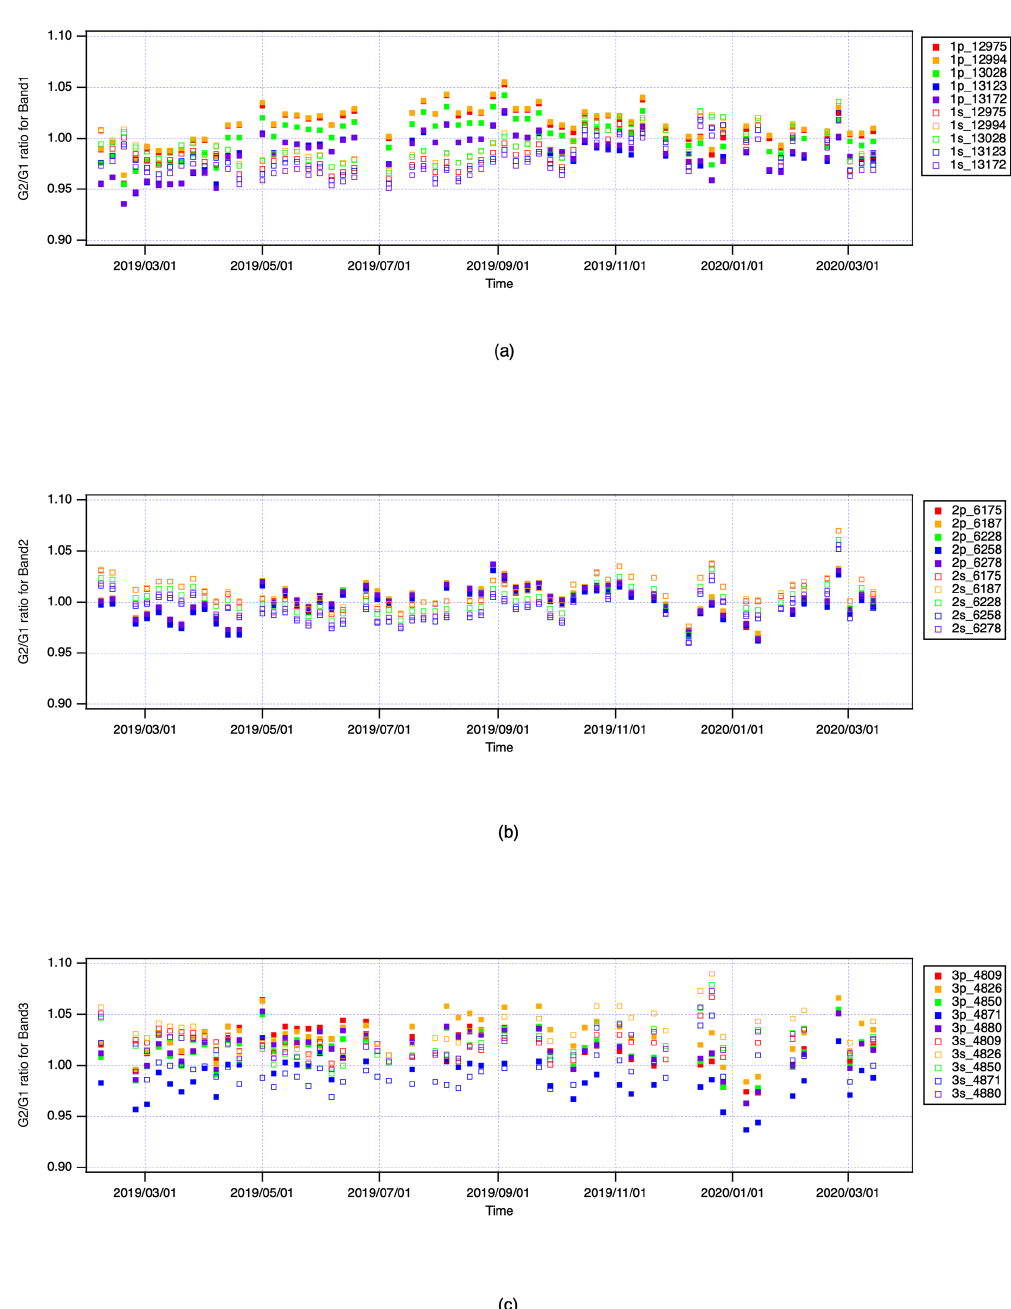
Figure 12. Inter comparison of radiance spectra between TANSO-FTS on board GOSAT (G1) and TANSO-FTS-2 on board GOSAT-2 (G2): (a) band 1, (b) band 2, and (c) band